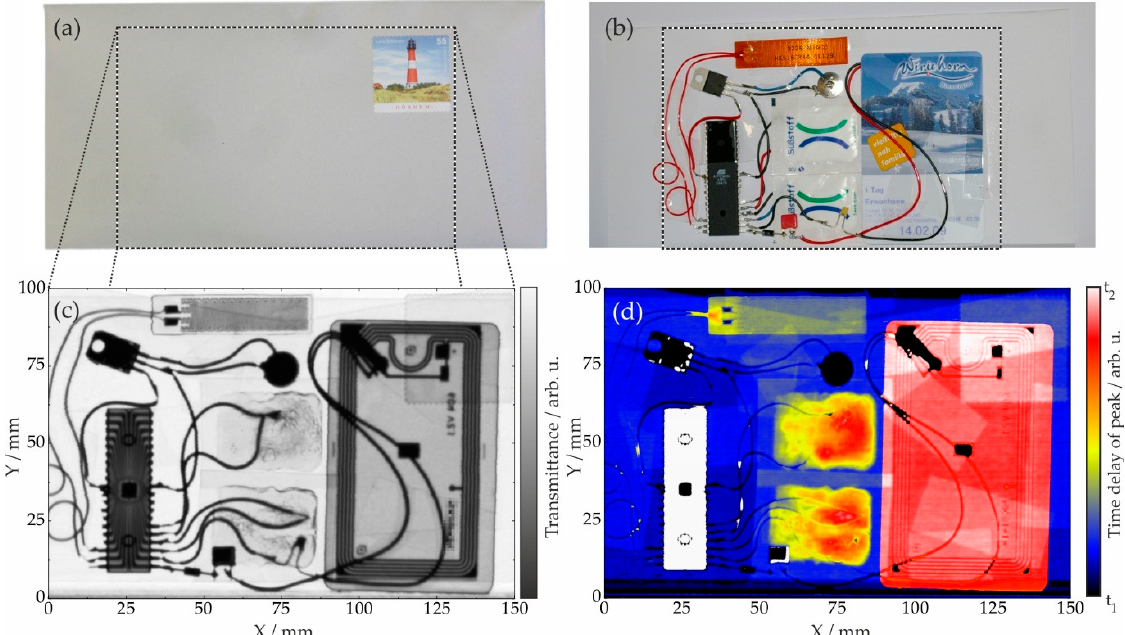
Figure 1. Terahertz imaging example of a mail envelope containing suspicious ingredients (mock-up for demonstration purposes). This measurement provides more than one million pixels, but was taken with a solid-state-laser-based terahertz time-domain spectroscopy (TDS) system filling an optical table with an overall measurement time of several hours. ( a ) Closed envelope as measured with indication of scanned area. ( b ) Content of the envelope consisting of several layers of paper, a radio-frequency identification (RFID) ski card, various wires and electronic components as well as two bags of substances. ( c ) Terahertz transmission image based on the transmittance. ( d ) False-color image retrieved by the evaluation of the time delay of the peak in each pixel’s waveform.